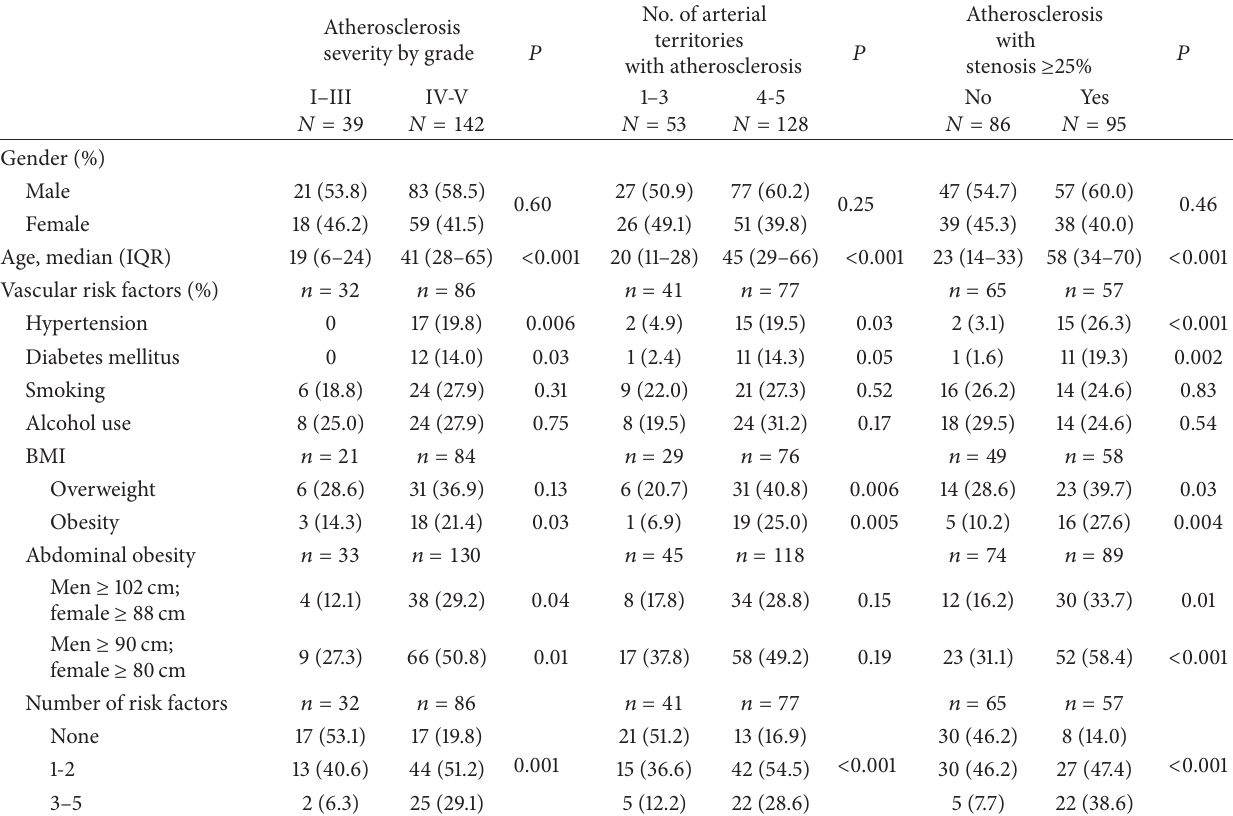
Table 4: Demographic data and vascular risk factors according to atherosclerosis